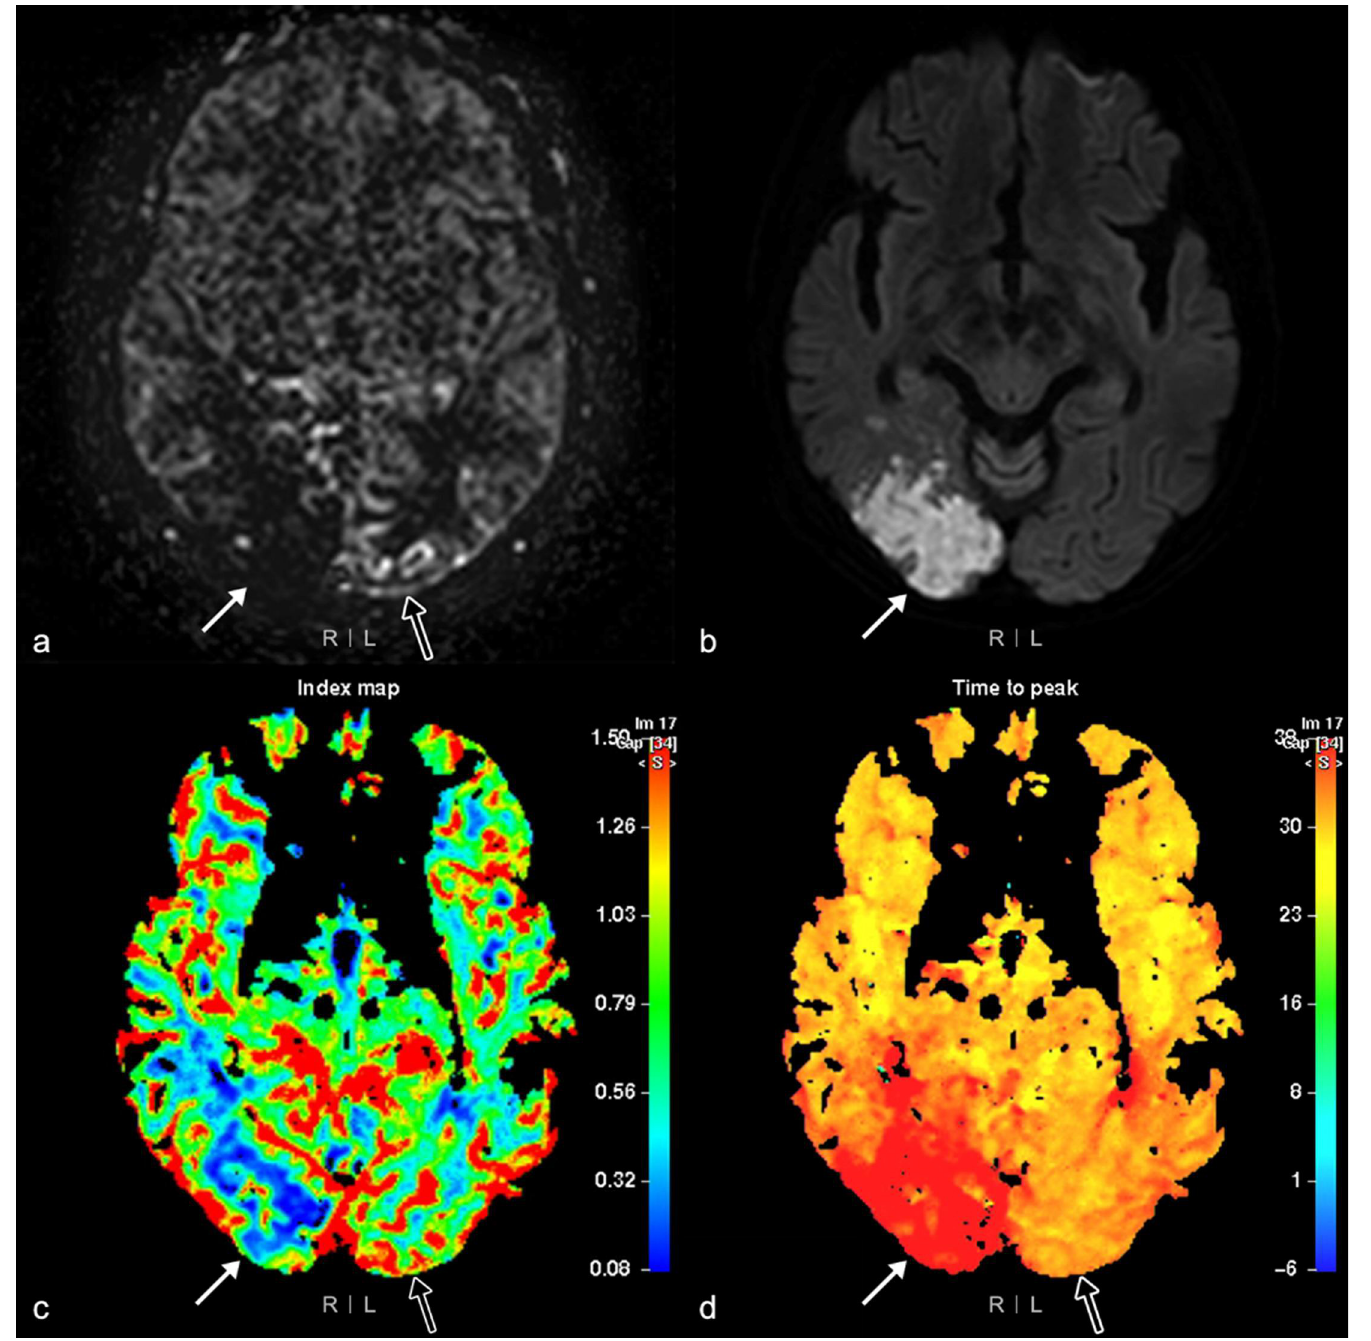
Fig 4. Arterial spin labeling (ASL) rank II and IV perfusion abnormalities. MRI of the brain of a 78-year-old woman with a left visual field defect. (a) ASL imaging shows a rank IV perfusion abnormality; positive parenchymal perfusion deficits (PPD) in the right occipital area (arrow); (b) Diffusion weighted imaging (b = 1,000) shows a high signal intensity (arrow); (c) cerebral blood flow (CBF) and (d) time to peak (TTP) maps show matched perfusion defects (arrow) in the same area. (a) A rank II perfusion abnormality is visualized as positive hyperintense vessel signals without PPD (open arrow) using ASL imaging, and a normal (open arrow) is seen in the left occipital area on (c) CBF and (d) TTP